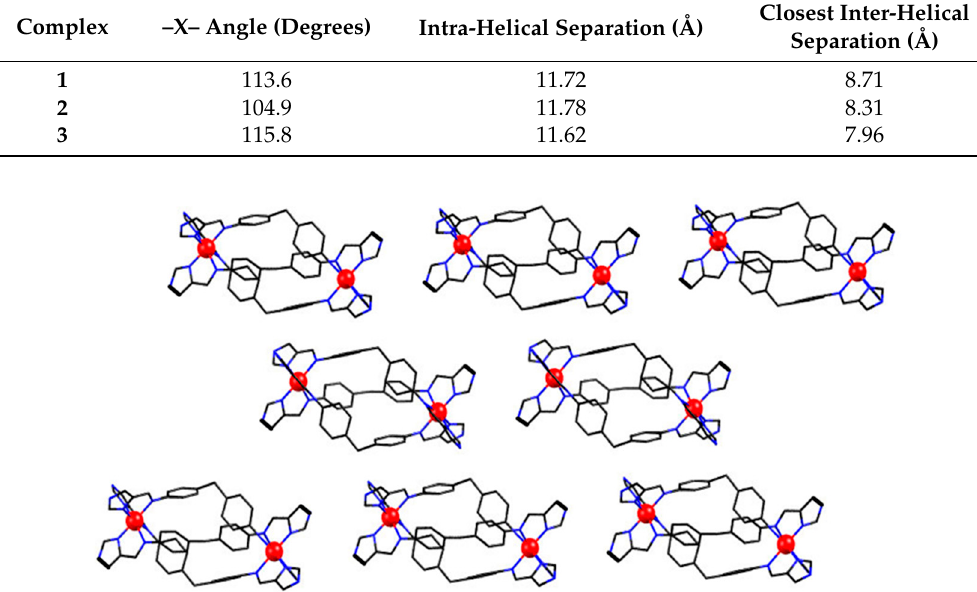
Figure 4. Schematic representation of the crystal packing structure of 1 at 100 K, demonstrating the formation of 2D sheets of interdigitated helicates. Solvent molecules and counter ions have been excluded for clarity. Mixed spin state populated Fe(II) metal centres are represented by red spheres.